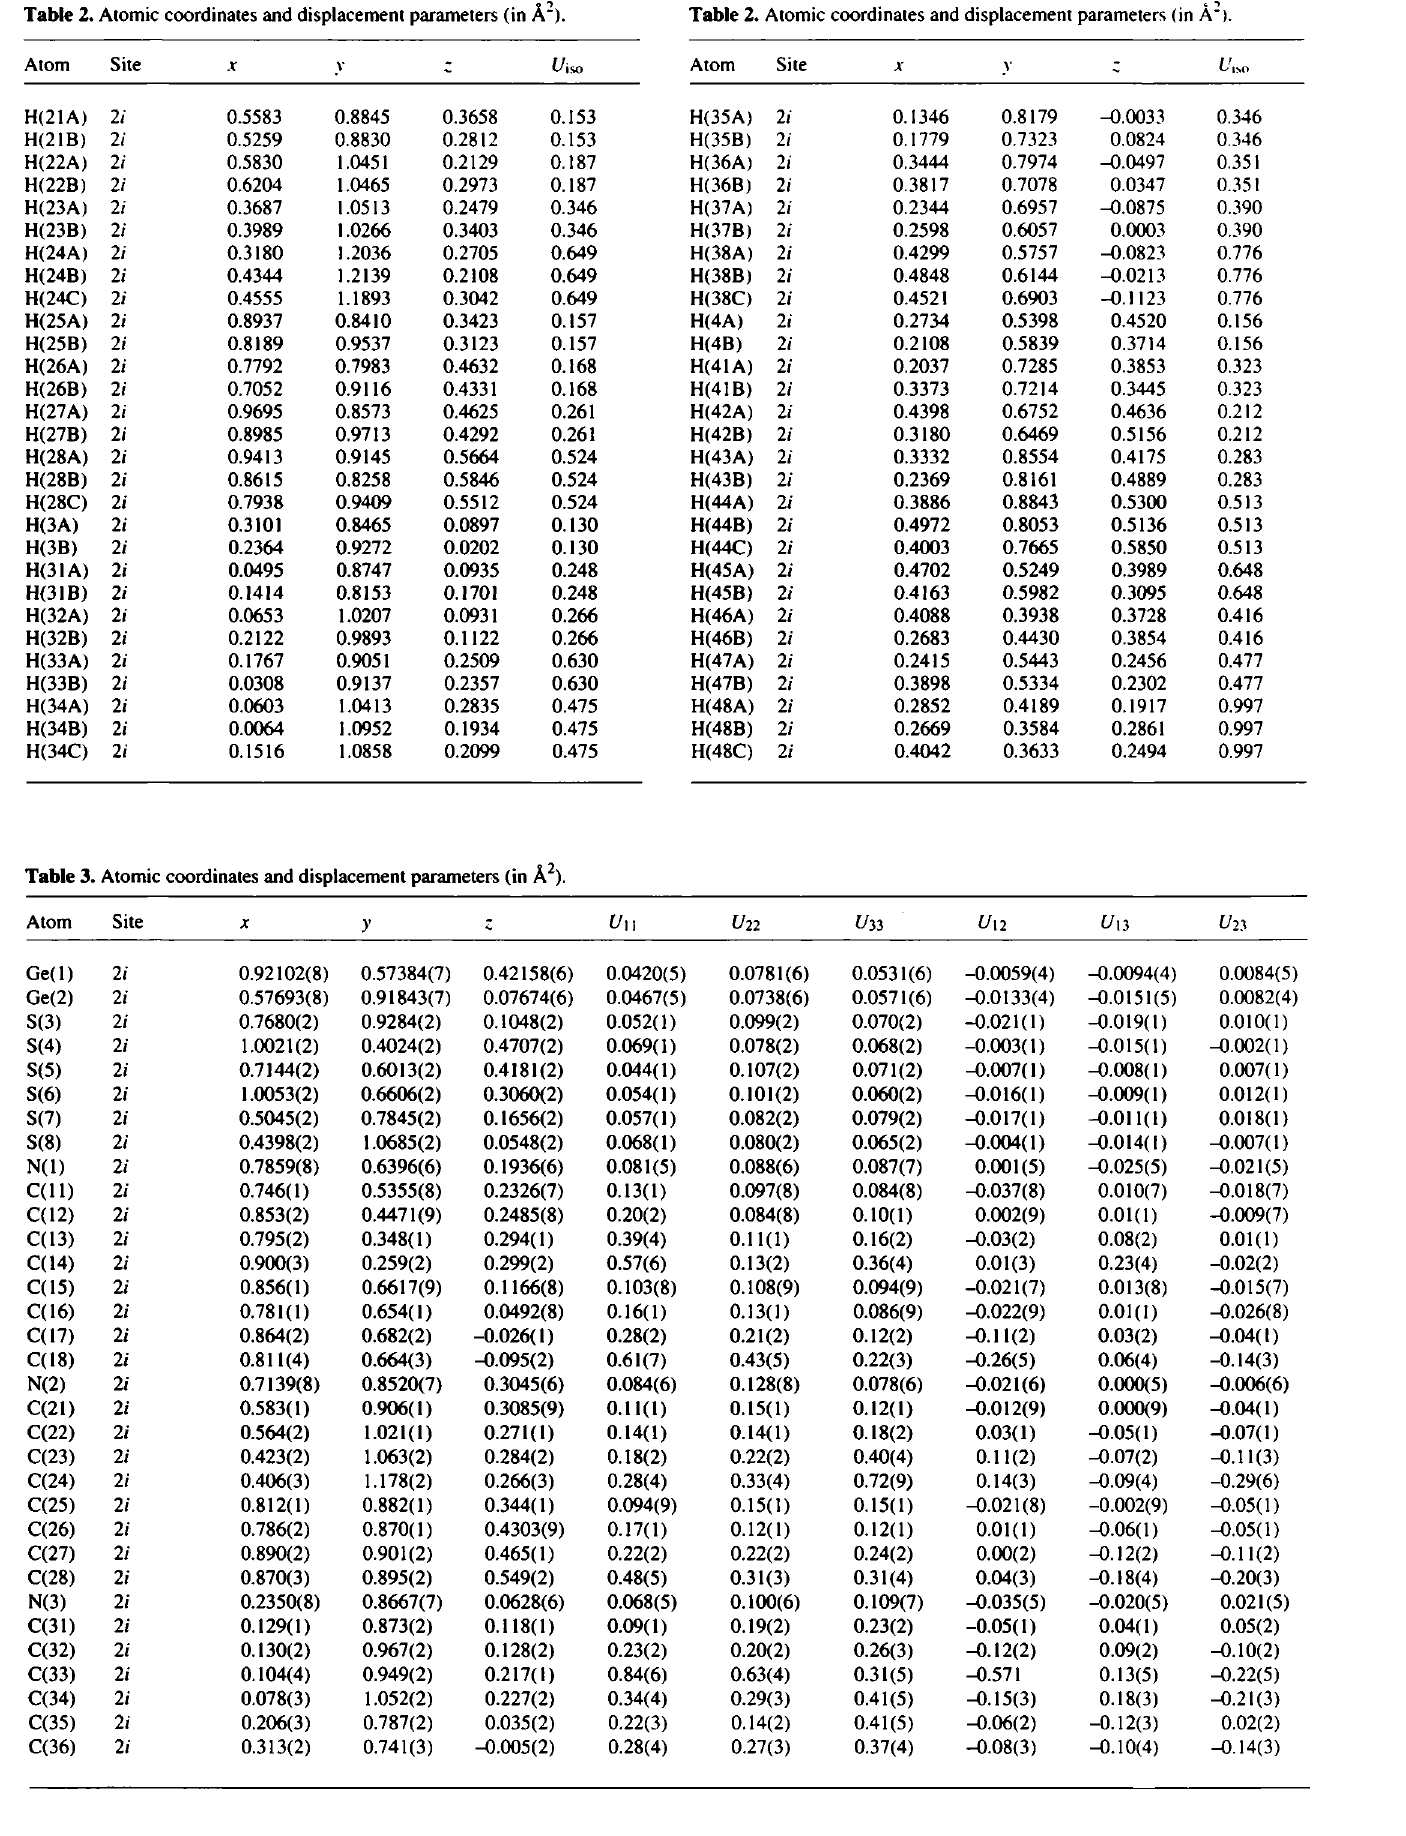
Table 3. Atomic coordinates and displacement parameters (in Ä 2